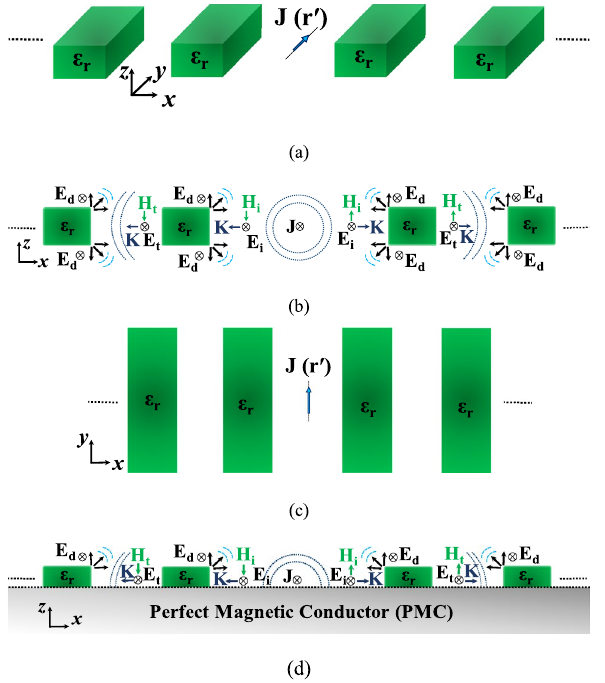
Figure 5. Electric current source in between dielectric slabs, ( a ) rectangular dielectric slabs “isometric view”, ( b ) side-view “propagation mechanism”, ( c ) top-view, and ( d ) unidirectional radiation “backed by PMC”.